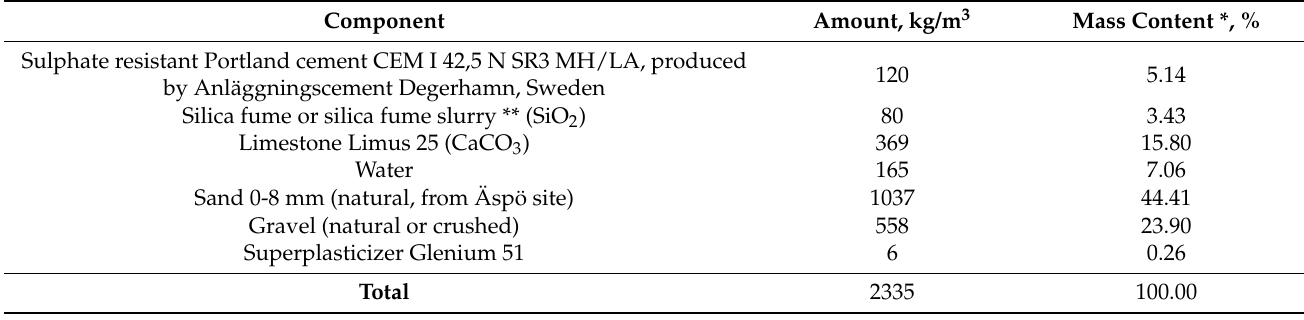
Table 3. Composition of low-pH concrete B200 for plug construction in KBS-3 repositories [51]. Component Amount, kg/m 3 Mass Content *,